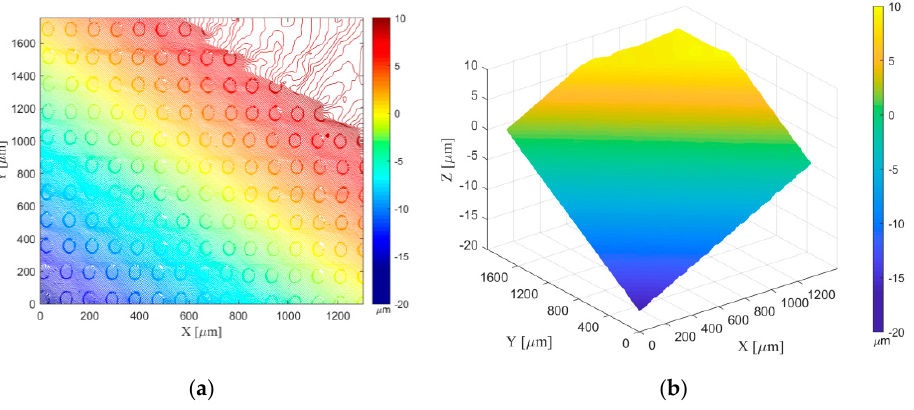
Figure 3. Reconstruction of the measured surface with its raw measurement data: ( a ) contour plot; ( b ) surf plot.